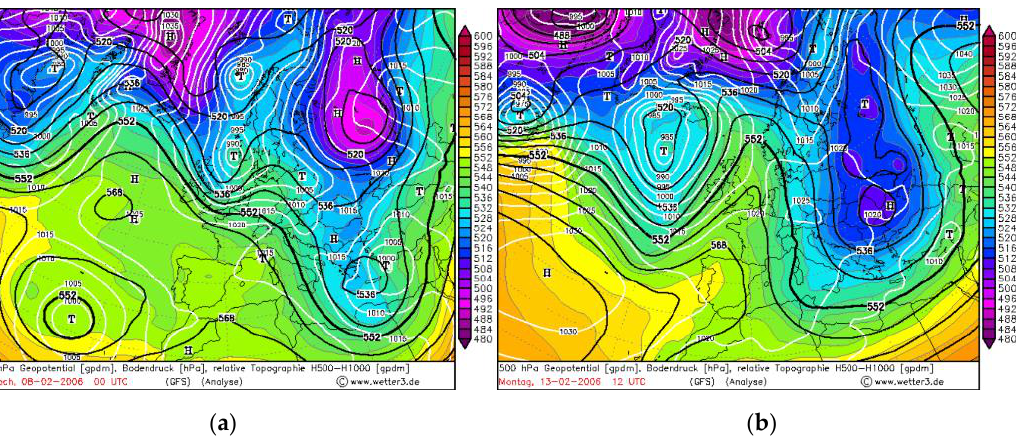
Figure 6. Weather maps for 8th February ( a ) and 13th February ( b ) 2006. The maps show the 500 hPa geopotential (black contours), sea-level pressure (white contours) and relative topography H500–H1000 (color scale) [15].